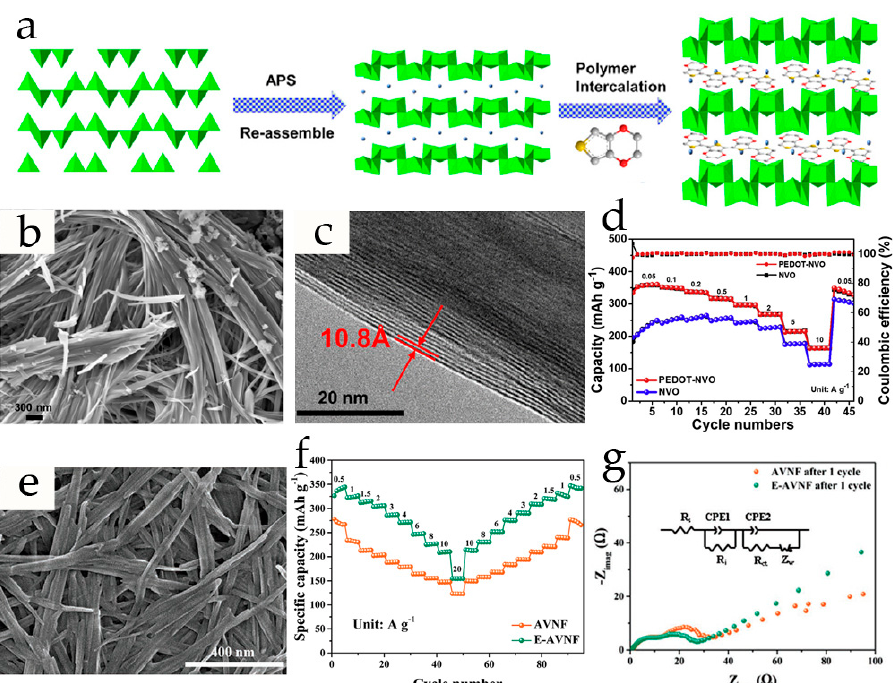
Figure 7. ( a ) Scheme of structural changes during the preparation of PEDOT-NVO [87]; ( b ) SEM of PEDOT-NVO [87]; ( c ) HRTEM of PEDOT-NVO [87]; ( d ) Rate capability of NVO and PEDOT-NVO at different current densities [87]; ( e ) SEM image of E-AVNF [58]; ( f ) Nyquist plots of AVNF and E-AVNF after 1st cycle [58]; ( g ) Specific capacities of AVNF and E-AVNF electrodes at different current densities [58].